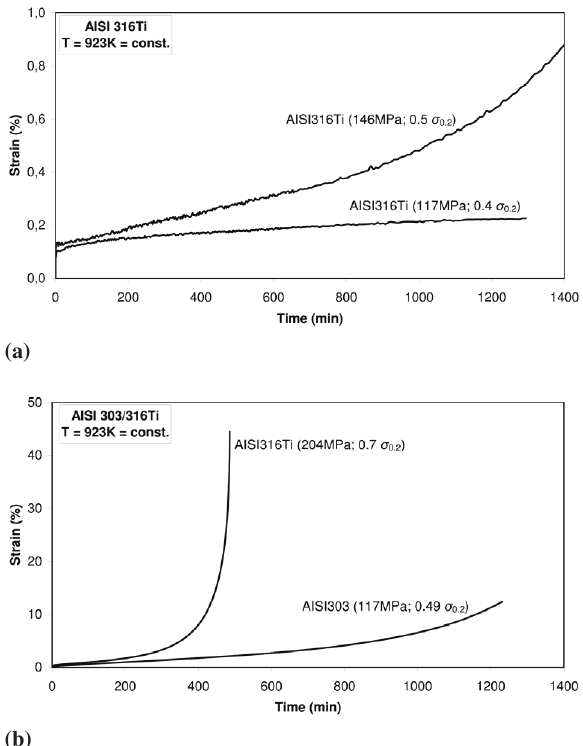
Figure 5. Creep behavior of AISI 303 steel and AISI 316Ti steel at temperature of T D 923 K. a) AISI 316Ti steel ( (cid:2) D 117 MPa; (cid:2) D 146 MPa). b) AISI 303 steel ( (cid:2) D 117 MPa) and AISI 316Ti steel ( (cid:2) D 204